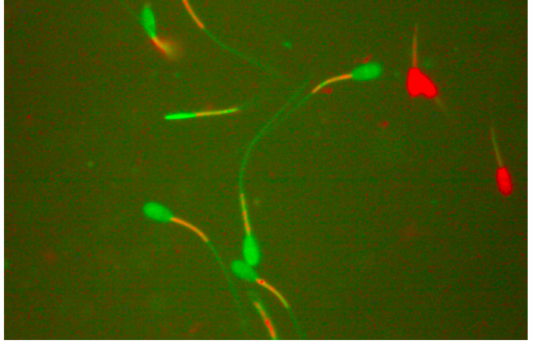
Figure 3. The stained orange or bright green fluorescence of the sperm midpiece was considered to indicate mitochondrial membrane potential activity, whereas the sperm midpiece with matte color indicated no mitochondrial membrane potential